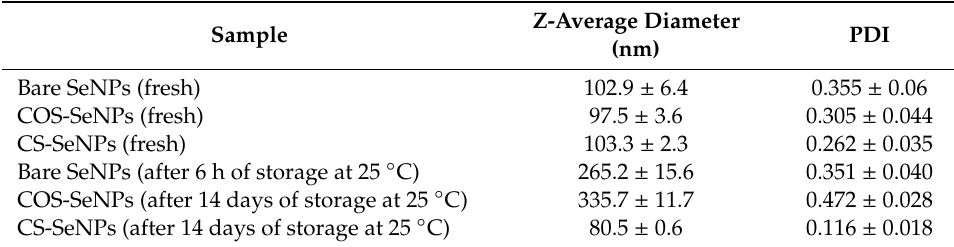
Table 2. The dynamic light scattering (DLS) results for bare SeNPs, COS-SeNPs, and CS-SeNPs ( n =